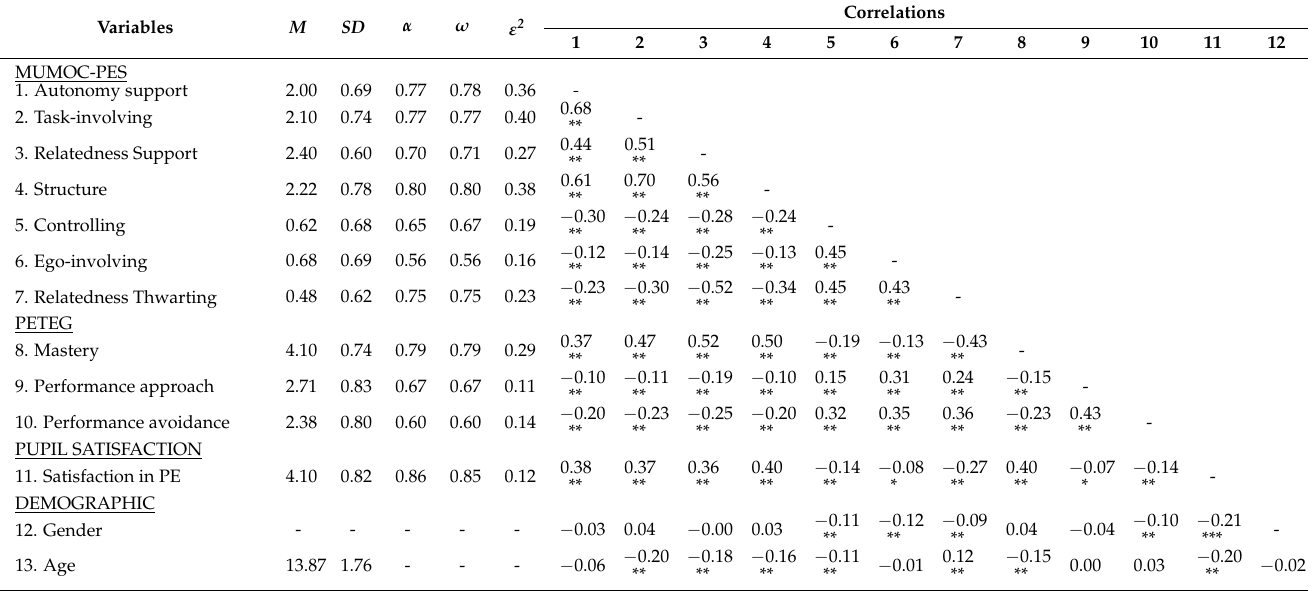
Table 2. Means ( M ), Standard Deviations, Cronbach’s α , McDonald’s omega ( ω ) Correlations among the examined variables and Effect Sizes ( ε 2 ) concerning between-Classes